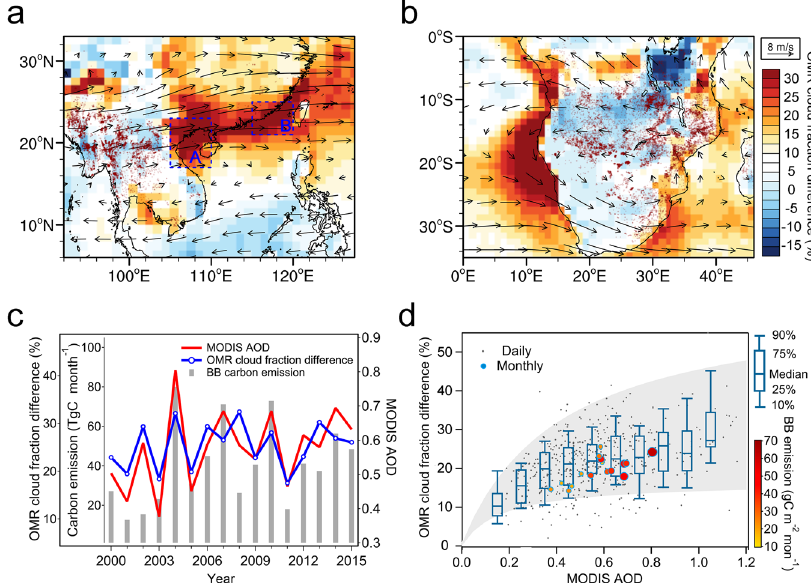
Fig. 1 Observation minus reanalysis (OMR) difference in cloud fraction and its relationship to aerosol optical depth (AOD). a , b OMR differences in cloud fraction (with MODIS cloud amount as the observation) together with 700 hPa wind fi elds in March in Asia and August in Africa, respectively, during 2000 – 2015. c Time series of monthly averaged biomass-burning (BB) carbon emission, OMR difference in cloud fraction (with MODIS cloud amount as the observation), and MODIS AOD for Asia in March (the region for averaging is denoted in Supplementary Fig. 3a). d Cloud enhancement as a function of AOD in subtropical southeastern Asia in March during 2000 – 2015. Note : The dark red dots in ( a ) and ( b ) show satellite-detected fi re counts. The blue boxes labeled A and B in ( a ) de fi ne regions with the highest OMR values for further analysis in Fig. 2. In ( d ), gray dots show daily regional results and the whisker-box plot gives the statistics of daily data with different AOD bins. The daytime cloud enhancement between the 10 th and 90 th percentiles is marked as the gray shading, and monthly results are color-coded with marker size indicating biomass-burning emission in the source